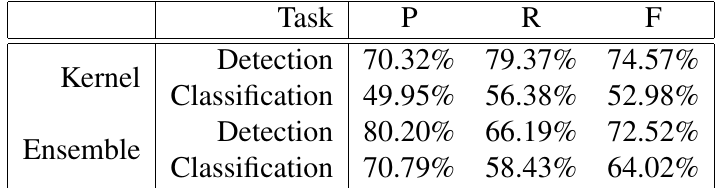
Table 5: Precision, Recall and F-measure estimates for RE the test set of the DDI